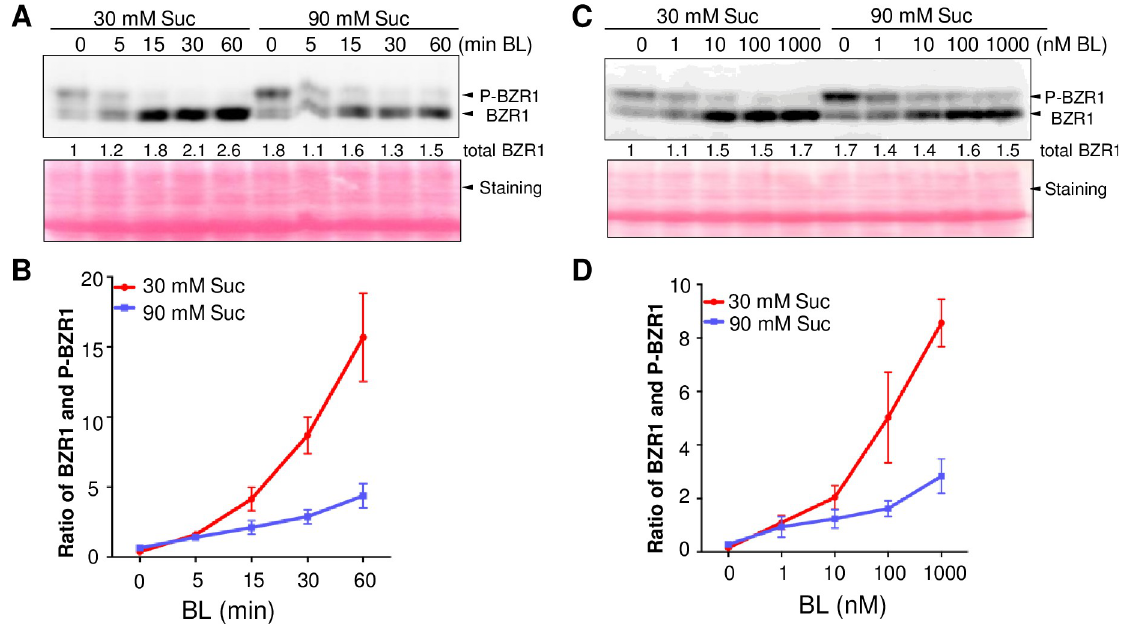
Fig 2. High level of sucrose inhibits BR-induced dephosphorylation of BZR1. (A) Immunoblot analysis of BZR1-CFP in seedlings grown in 30 mM or 90 mM sucrose medium after treatment with 1 μ M brassinolide (BL) for the indicated time. Numbers below the image show the relative level of total BZR1 protein. (B) Quantification of the ratio between dephosphorylated and phosphorylated BZR1 (P-BZR1) using results shown in (A) and two additional biological repeats. (C) Immunoblot of BZR1-CFP in seedlings grown for five days on media containing 30 mM or 90 mM sucrose and different concentrations of BL after two-day germination in 30 mM sucrose medium. The relative levels of total BZR1 protein are shown below the image. (D) Quantification of the BZR1/P-BZR1 ratio using results shown in (C) and two additional biological replicate samples. Error bars indicate the